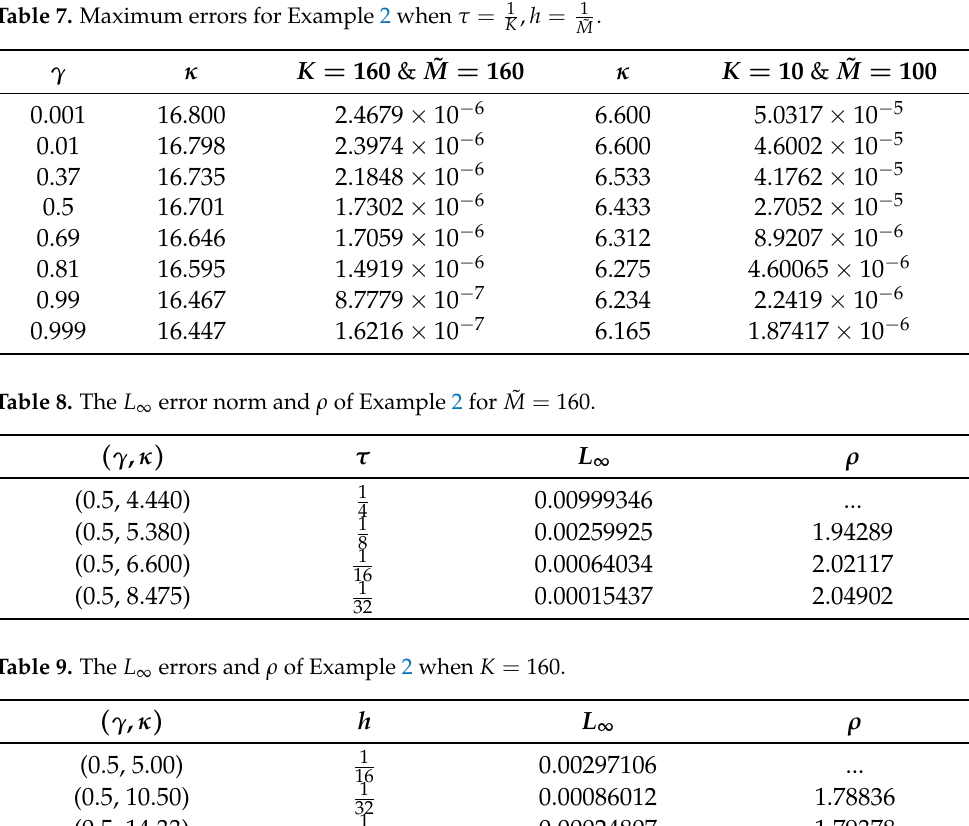
Table 7. Maximum errors for Example 2 when τ = 1